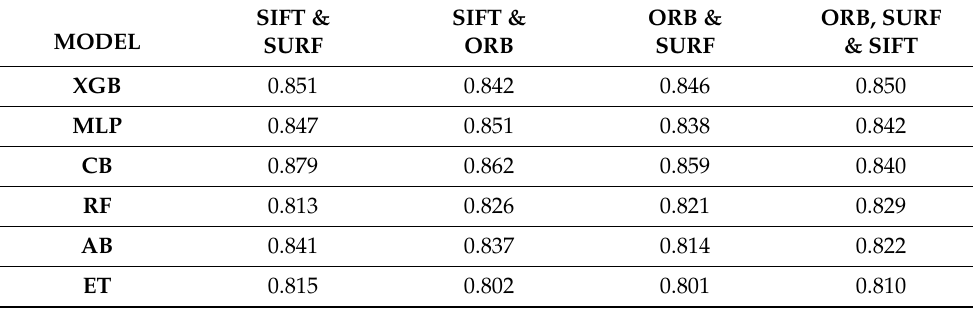
Table 4. The comparative performance of classifiers in terms of the accuracy used for the classification of IDC(+) and IDC(-) images using the simple fusion of standalone descriptors. Simple fusion refers to combinations, like SIFT-SURF, SIFT-ORB, ORB-SURF and